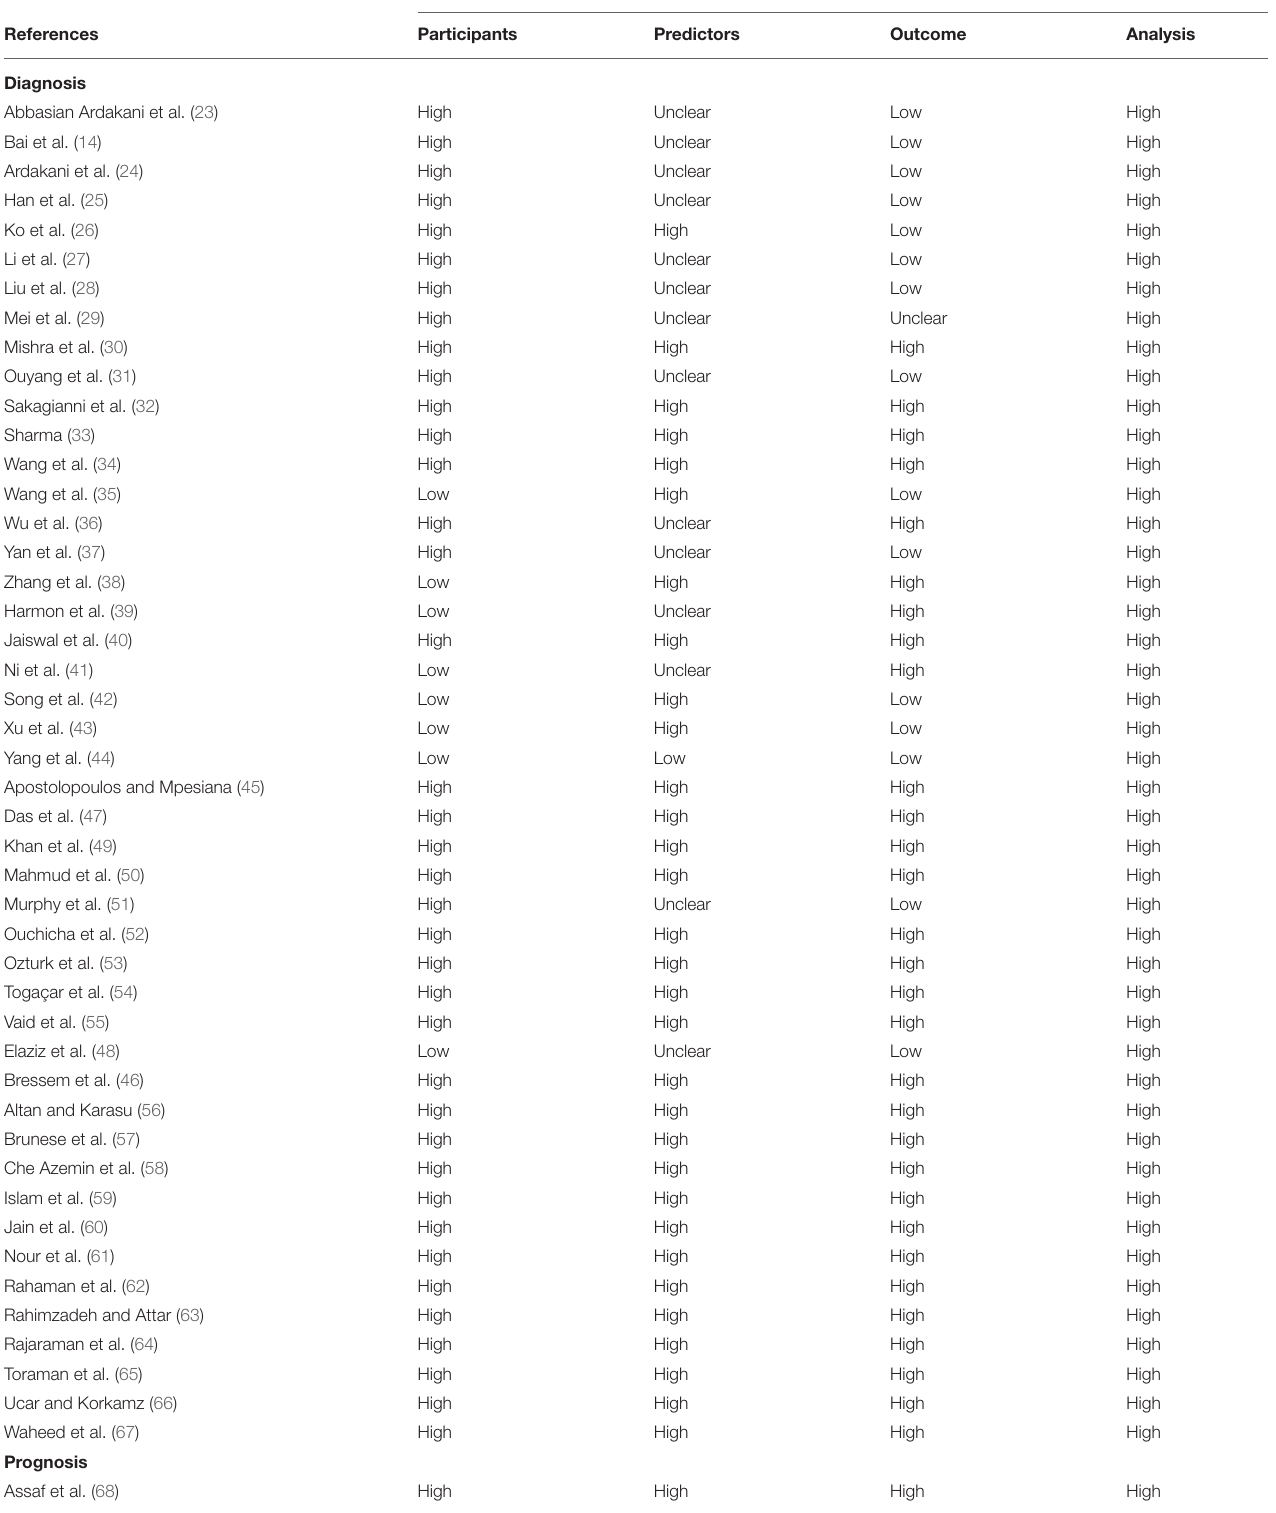
TABLE 1 | Risk of bias assessment (by